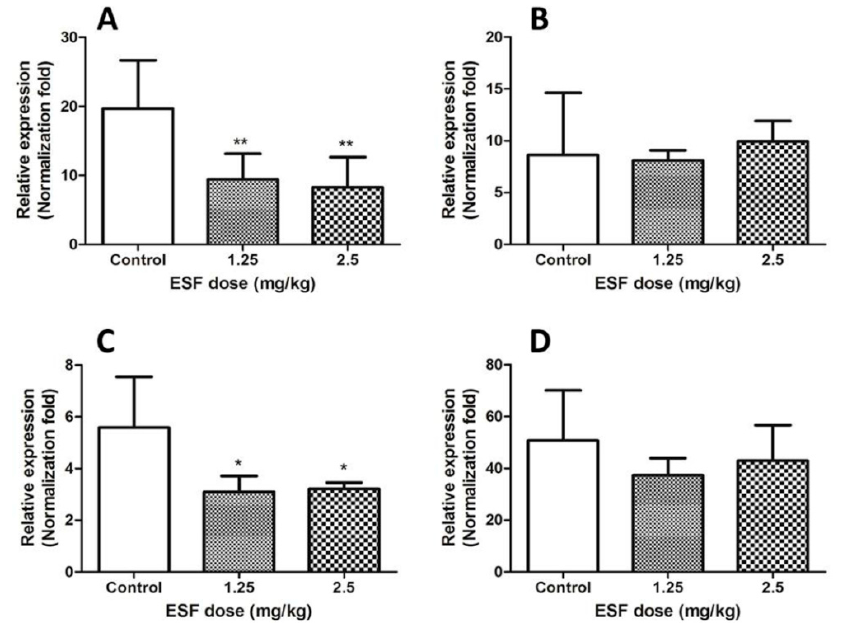
Figure 6. Effect of ESF on liver CPT-1, CPT-2, PPAR- α and LCAD mRNA in rats for two weeks. ( A ) The mRNA level of hepatic CPT-1; ( B ) The mRNA level of hepatic CPT-2; ( C ) The mRNA level of hepatic PPAR- α ; ( D ) The mRNA level of hepatic LCAD. Data are expressed as mean ± SD of each group (n = 6 per group). * p < 0.05, ** p < 0.01, compared with control group.